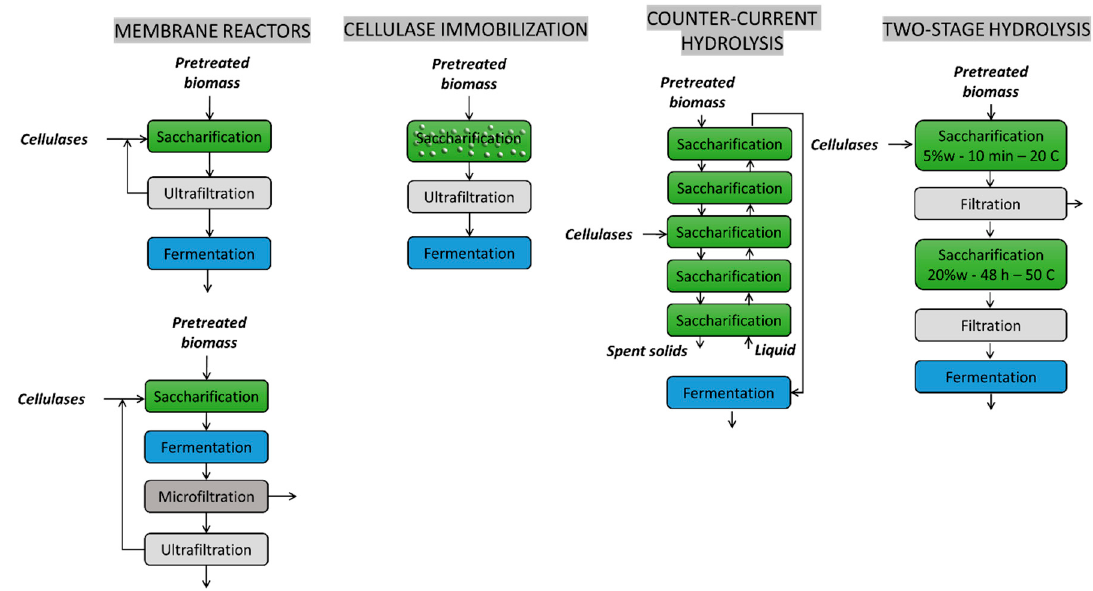
Figure 4. Novel bioreactor configurations for enzymatic hydrolysis.